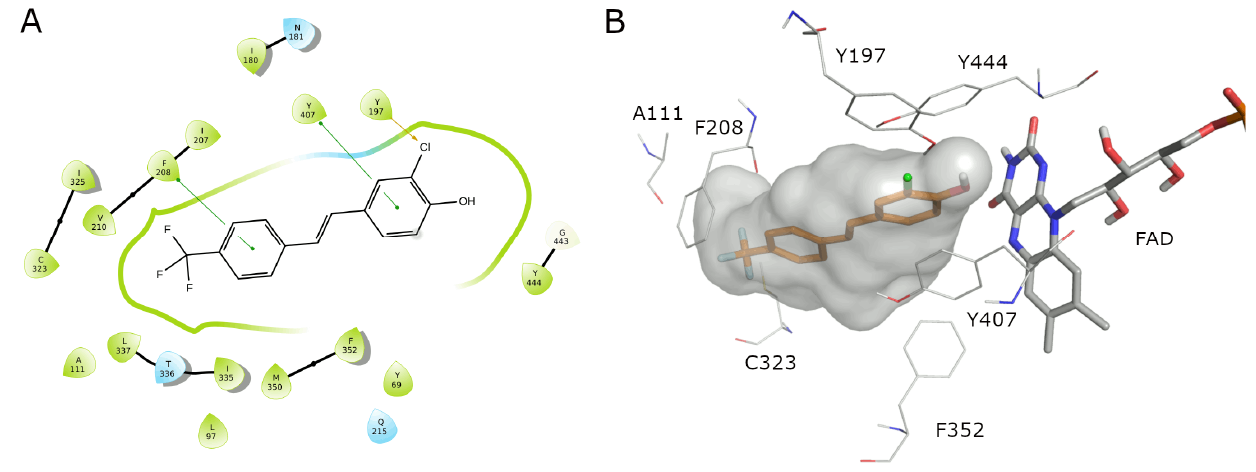
Figure 3. The catalytic site of MAO-A in complex with 4 . ( A ) The 2D ligand interaction diagram; ( B ) the best docked pose of ligand 4 (orange sticks) with the surrounding residues of MAO-A shown (grey lines).